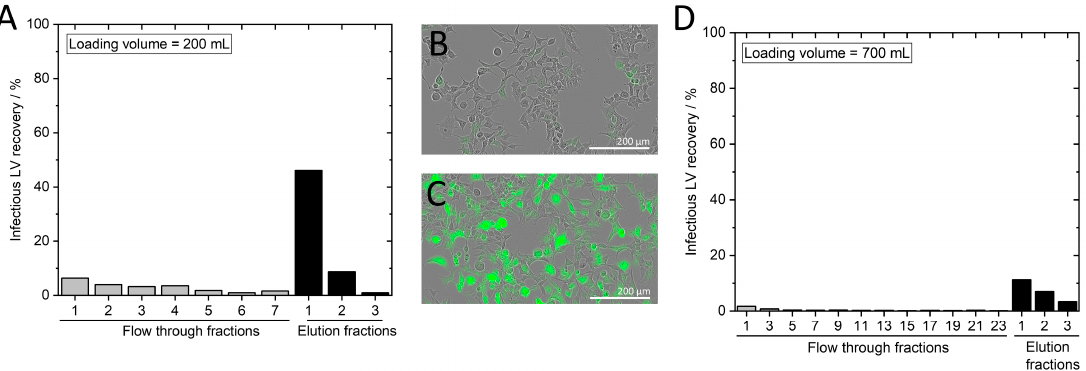
Figure 5. Identification of loading capacity. Infectious LV recovery for loadings of ( A ) 200 mL and ( D ) 700 mL. Phase contrast image merged with a green fluorescence channel image of HEK293T cells after incubation with a ( B ) flow through fraction or ( C ) elution fraction.